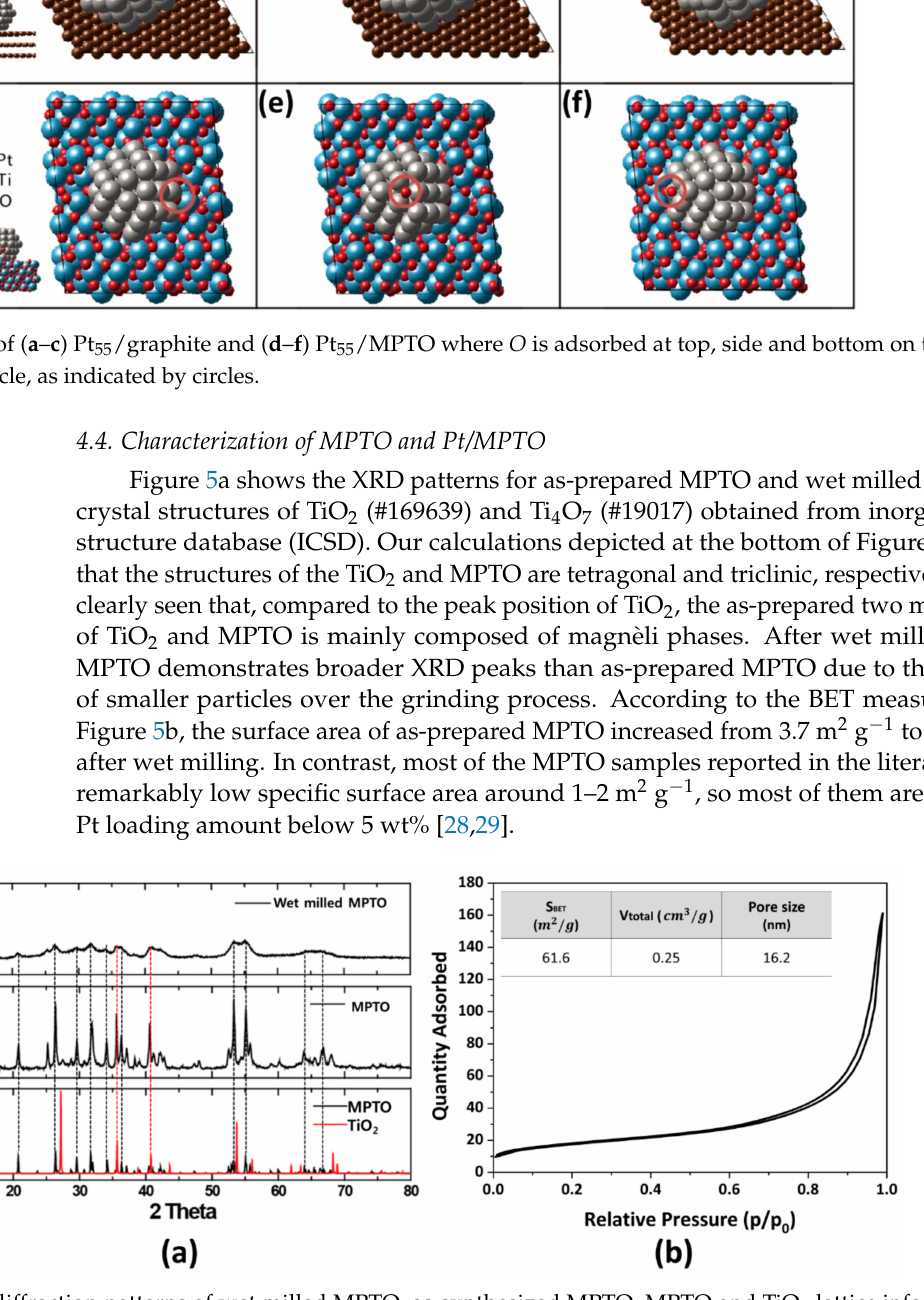
Figure 5. ( a ) X-ray diffraction patterns of wet milled MPTO, as-synthesized MPTO, MPTO and TiO 2 lattice information obtained from ICSD database. ( b ) N 2 adsorption/desorption isotherm of wet milled